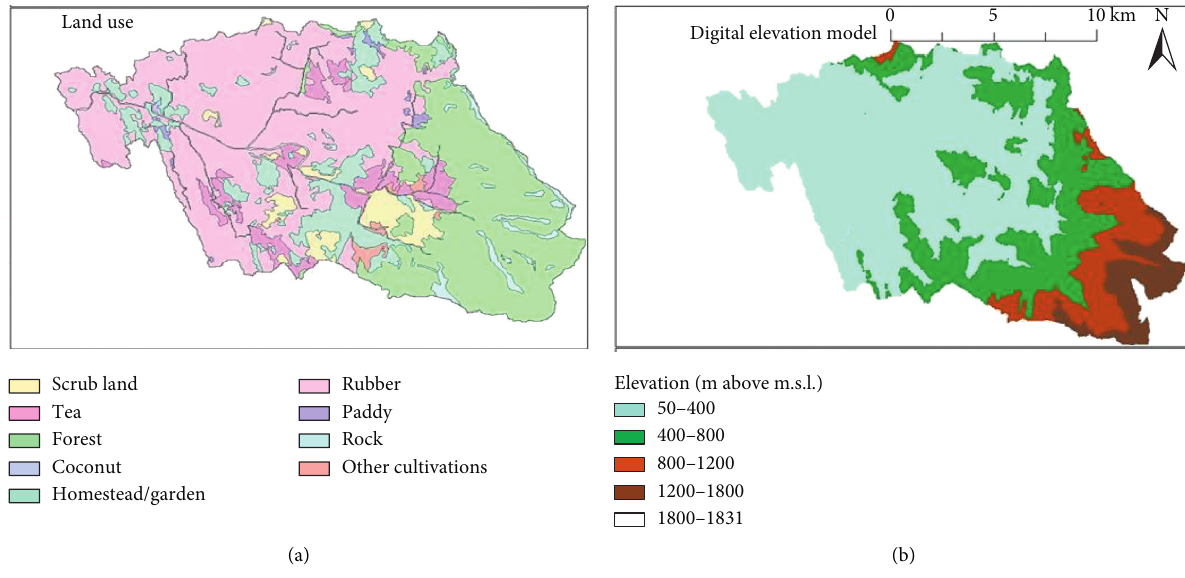
Figure 2: Land use and topography of Seethawaka river. (a) Land use pattern. (b) Digital elevation